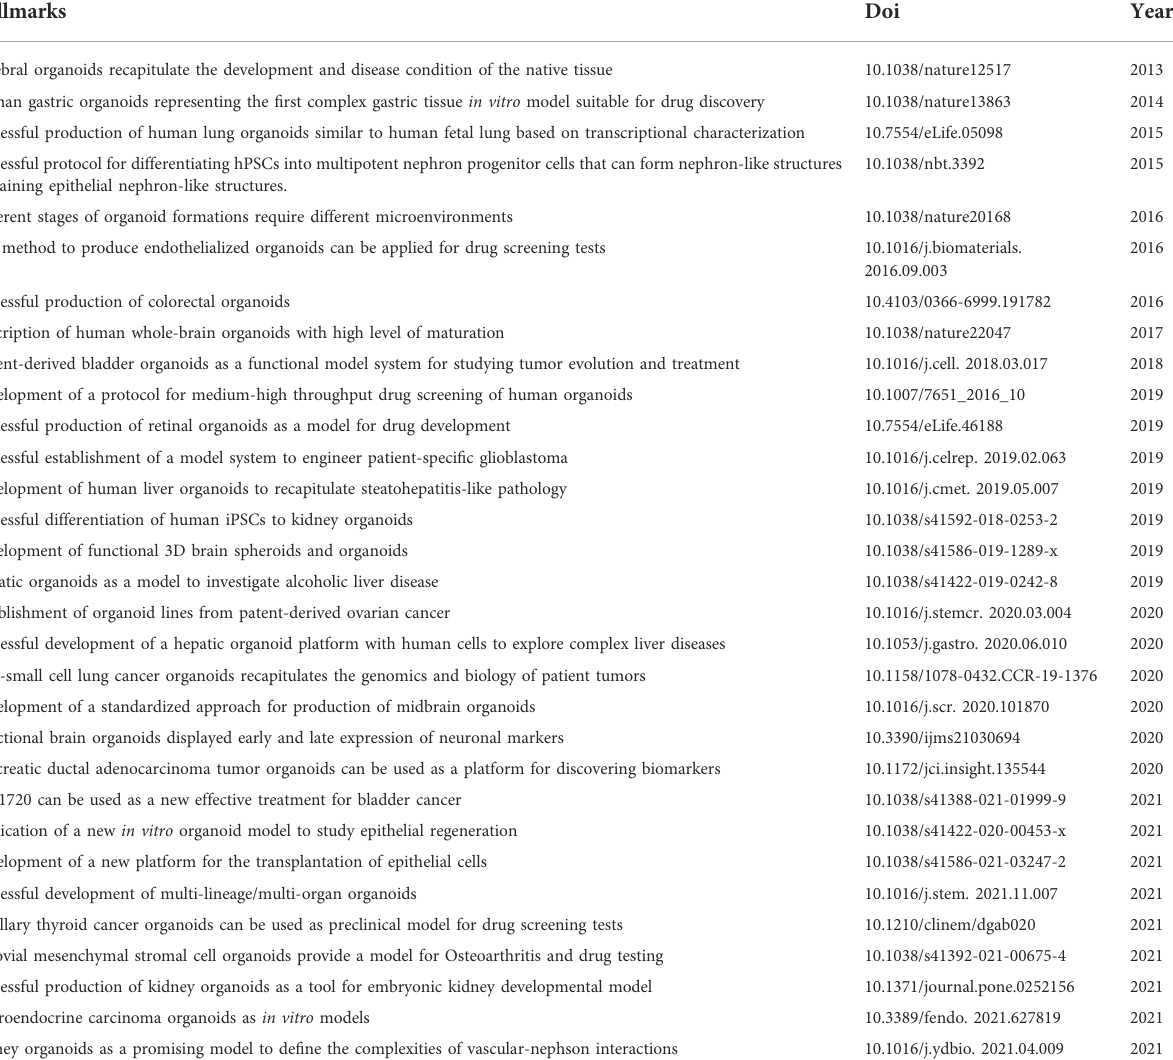
TABLE 1 Recent advances: hallmarks of organoids models.